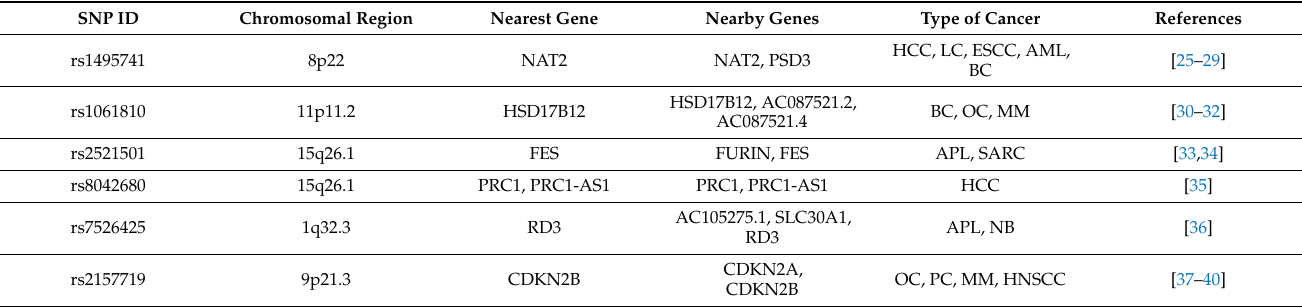
Figure 2. Schematic representation of SNPs selection. Table 1. Summary of the six SNPs jointly associated with T2D and